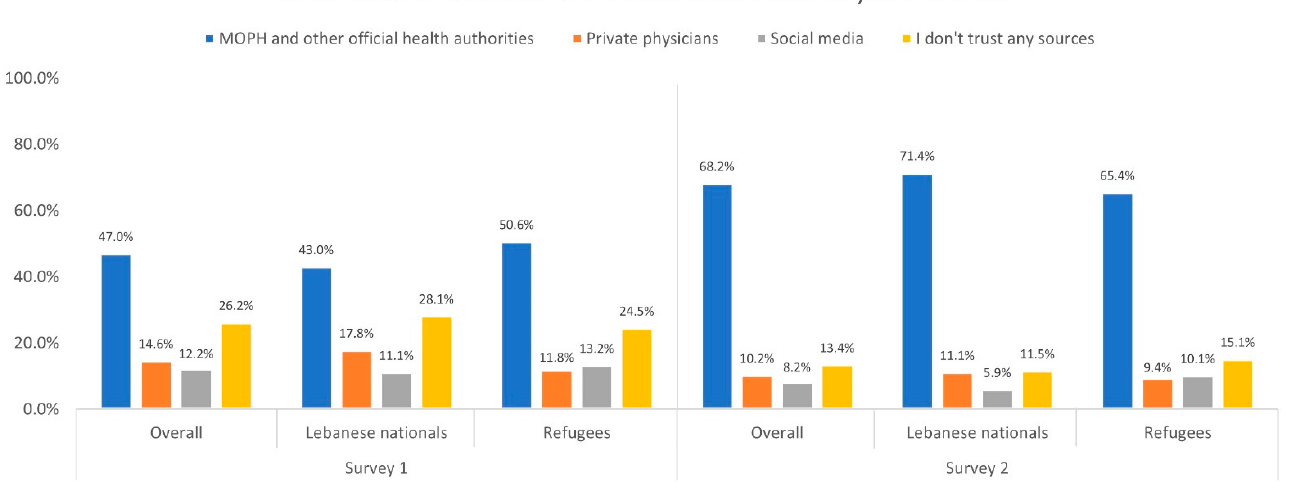
Figure 2. Most trusted sources of information regarding vaccines and health among overall study population and by nationality in Survey 1 and Survey 2.